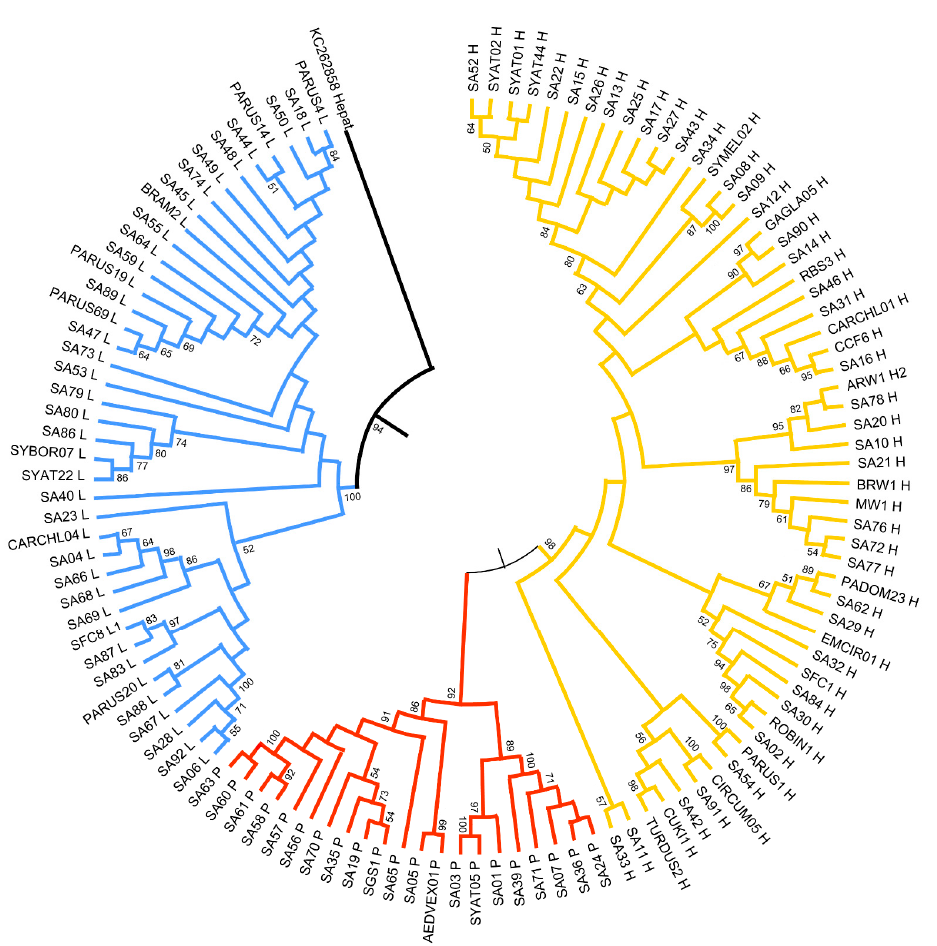
Figure 3. Neighbor-joining tree of the partial cytb gene (470 bp) of Plasmodium (red), Haemoproteus (yellow), and Leucocytozoon (blue) sequenced from Sardinian birds. Bootstrap values ( ≥ 50%) are provided. “SA” precedes novel lineages found in this study; other lineages are named based on their match to MalAvi lineages.